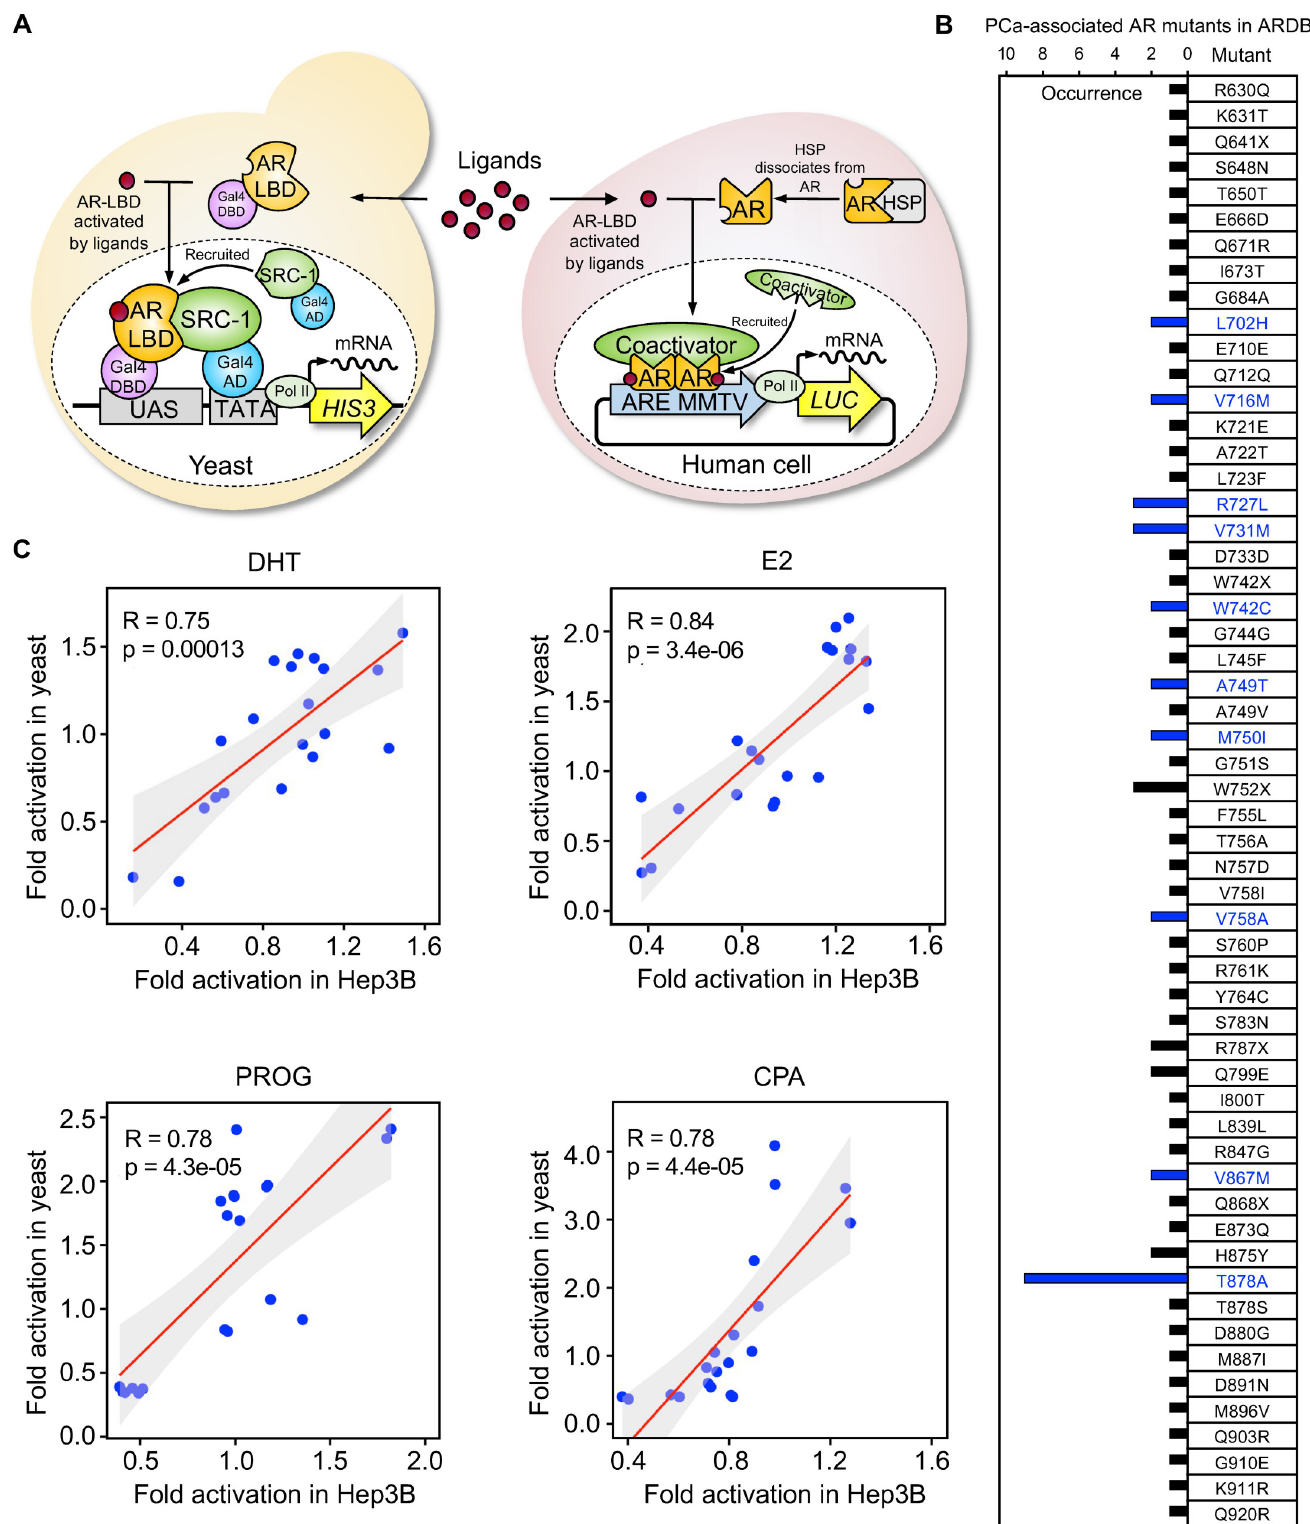
Fig 1. Correlation of AR-mediated reporter activities between designer yeast and mammalian systems. ( A ) Schematic representation of our designer yeast platform compared with the mammalian luciferase reporter system. ( B ) The list of 56 PCa-associated AR-LBD mutations accumulated in ARDB during a 22-year